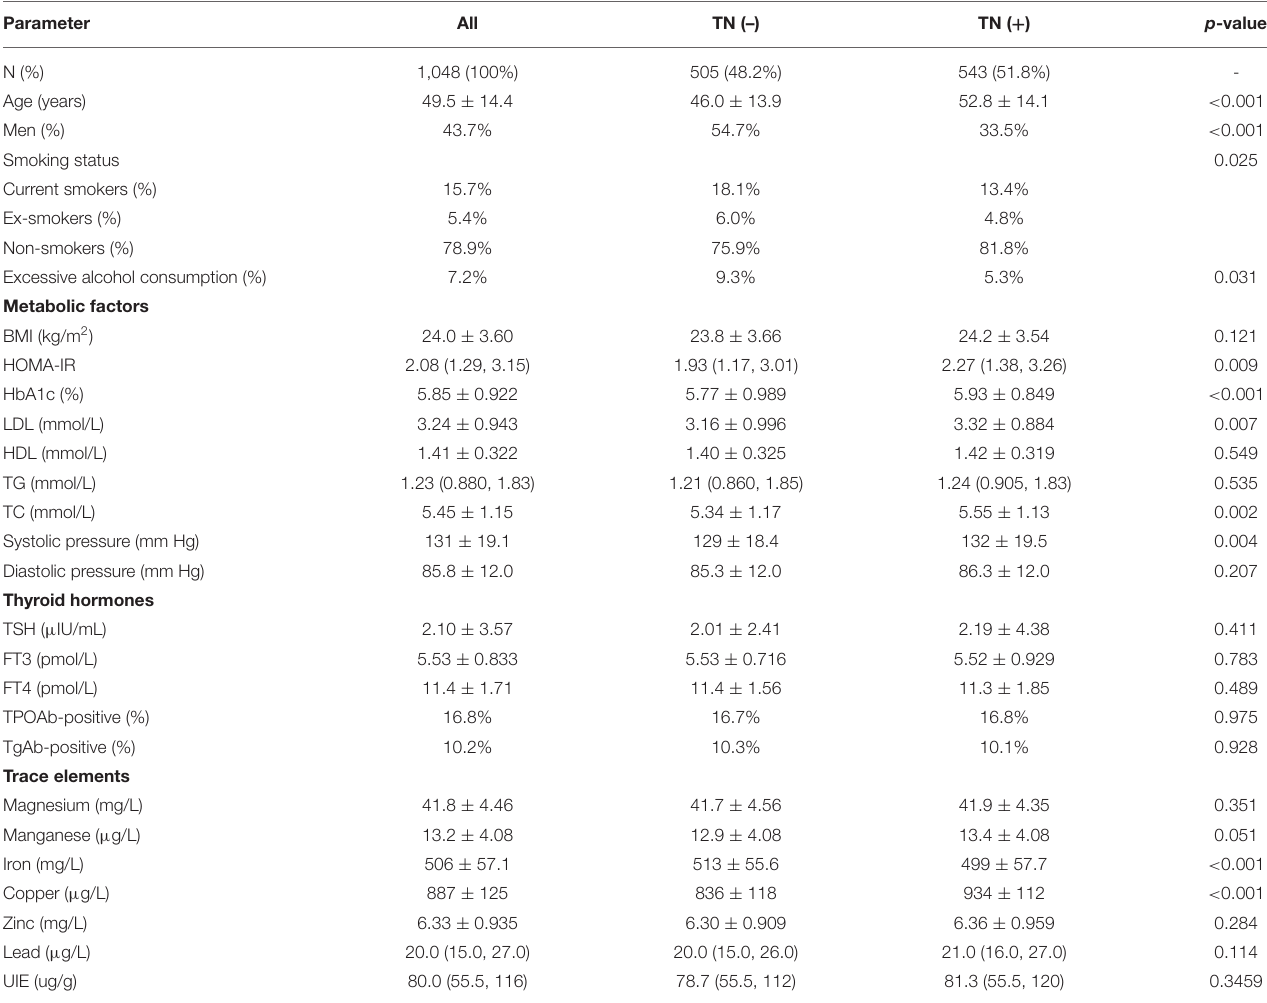
TABLE 1 | General characteristic of all subjects of those with and without thyroid nodules (TNs).